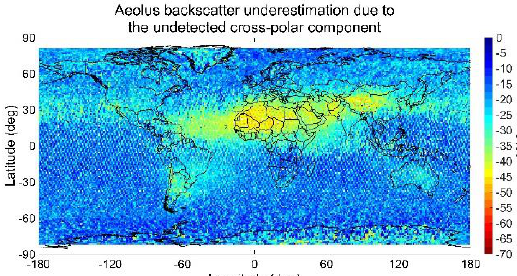
Figure 2: Global-scale underestimation of the aver- aged total backscatter coefficient at 355 nm for the year 2007, due to detection of only the co-polar com- ponent, based on LIVAS database results.